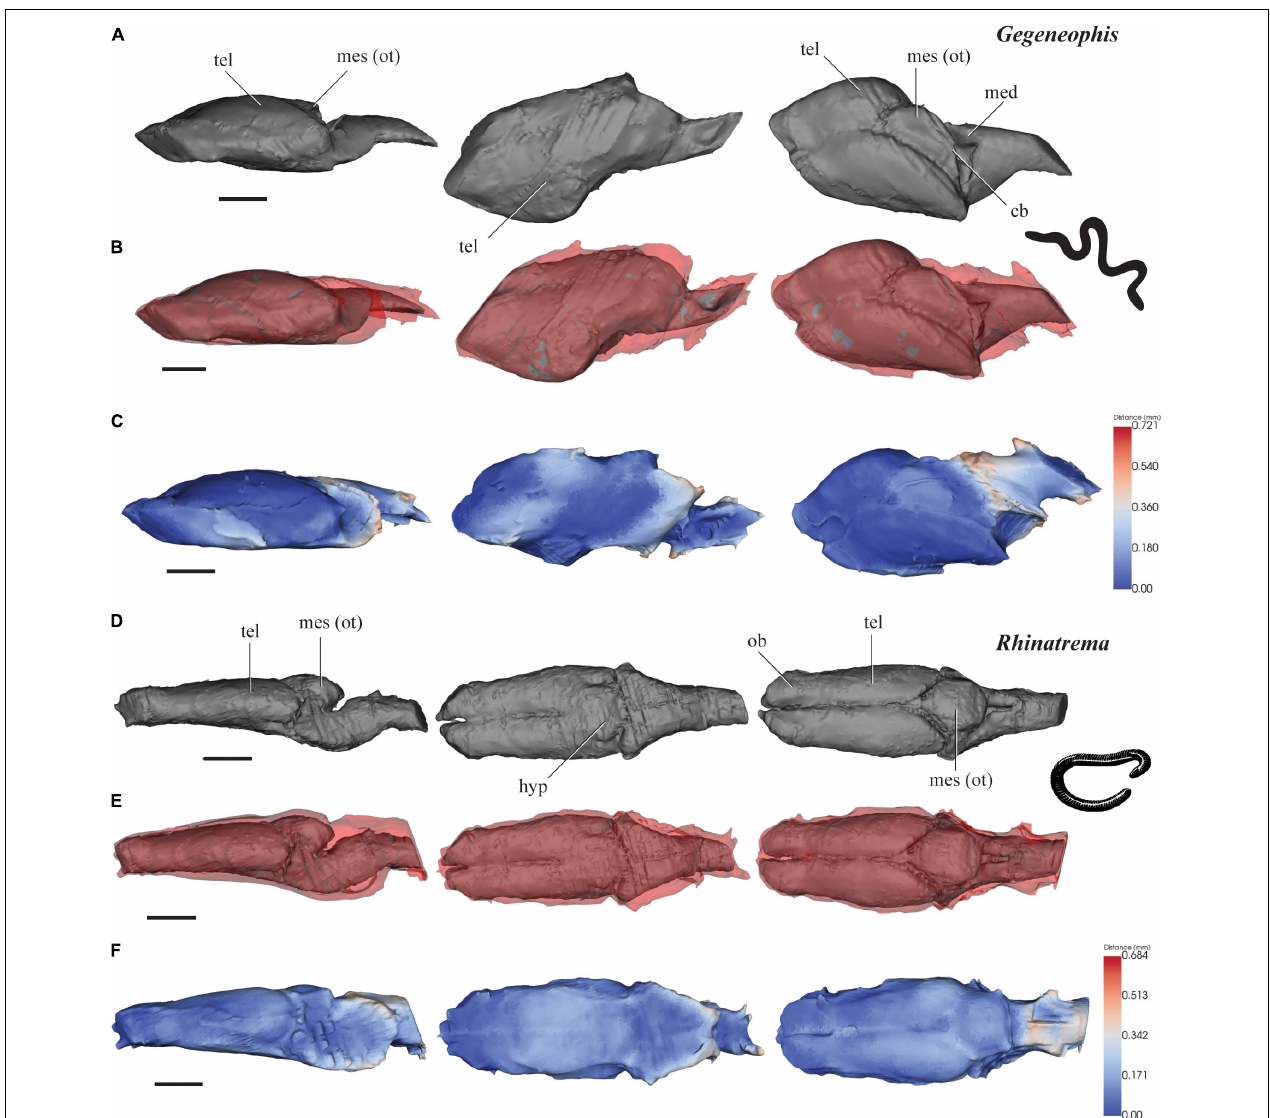
FIGURE 2 | 3D models of brains (gray), endocasts (red), and surface-surface distance heatmaps of two caecilians in left lateral, ventral and dorsal views. (A–C) Gegeneophis ; and (D–F) Rhinatrema . Anterior to the left. cb, cerebellum; med, medulla oblongata; mes (ot), mesencephalon/optic tectum; tel, telencephalon; ob, olfactory bulb. Scale 1